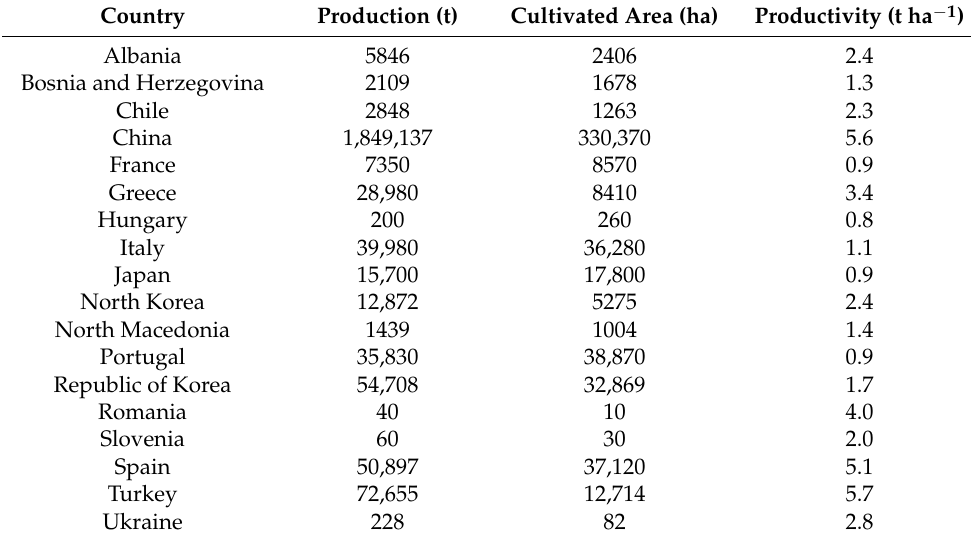
Table 1. Production (t), cultivated area (ha), and productivity (t ha − 1 ) of chestnut by country, in 2019